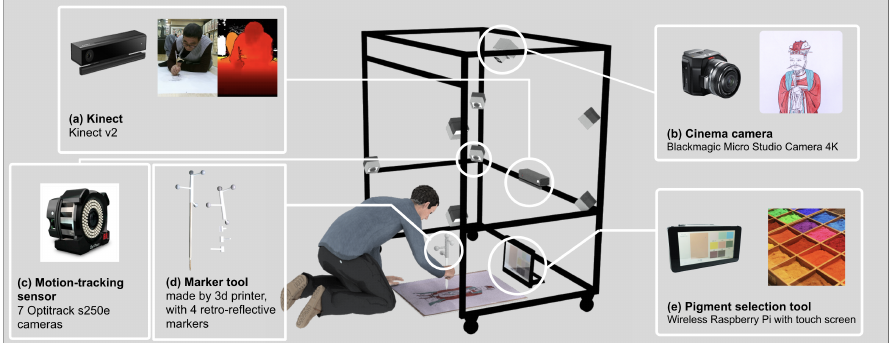
Figure 3. Hardware setup. The main structure of the proposed system is a cuboid-shaped aluminum frame equipped with contactless sensors such as a Kinect, a cinema camera, and a motion-tracking sensor. The marker tool attached to a brush is used by the motion-tracking sensor to detect the current pose of the brush. The pigment selection tool is used by the painter to specify the current pigment during